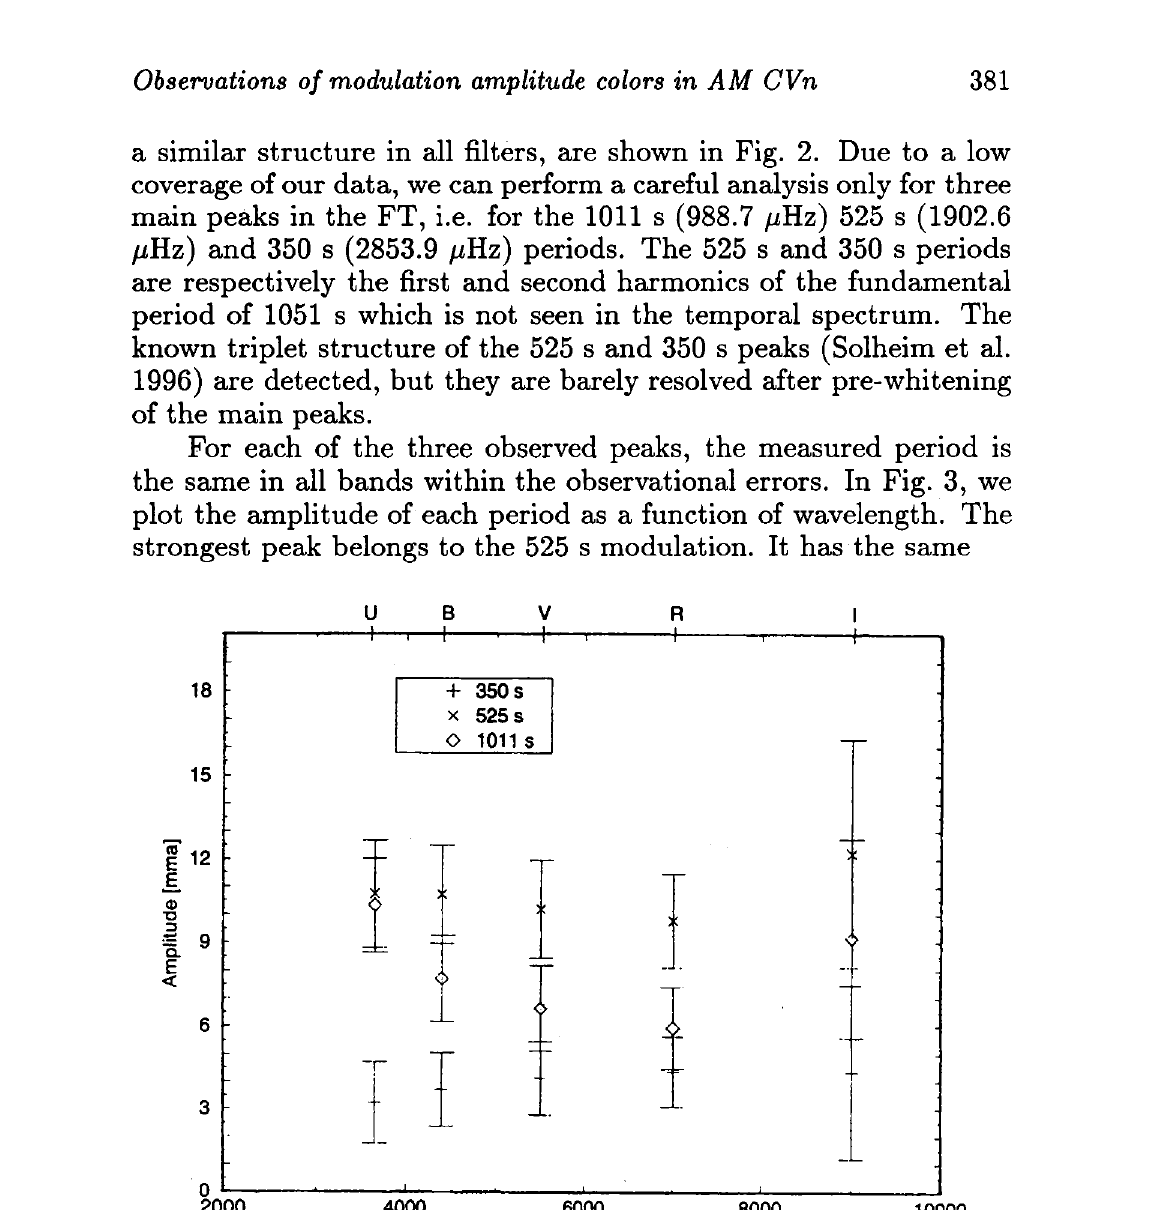
Fig. 3. Amplitude versus wavelength plot of the 525 s, 1011 s and 350 s modulations observed in the light curve of AM CVn in February 1994. amplitude in UBVRI, with a mean value of (10.7 ± 1.1)